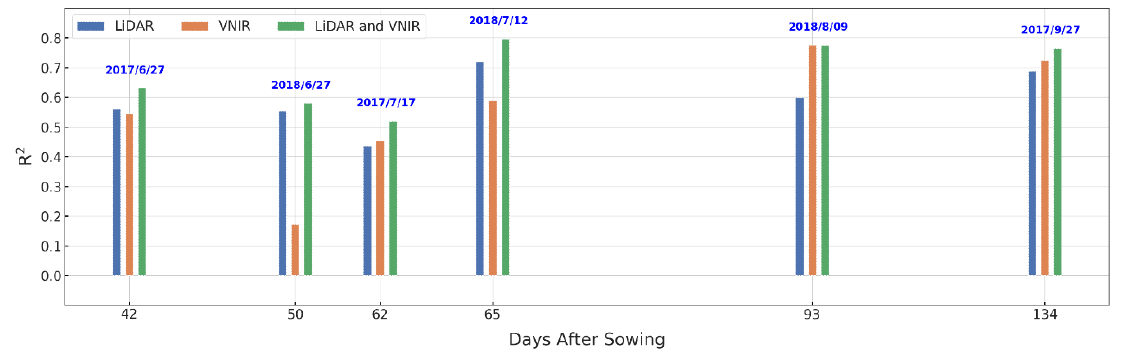
Figure 21. The R 2 of predicted biomass during the 2017 and 2018 growing seasons using the SVR models developed based on VNIR hyperspectral and LiDAR data for the hybrid calibration panels.